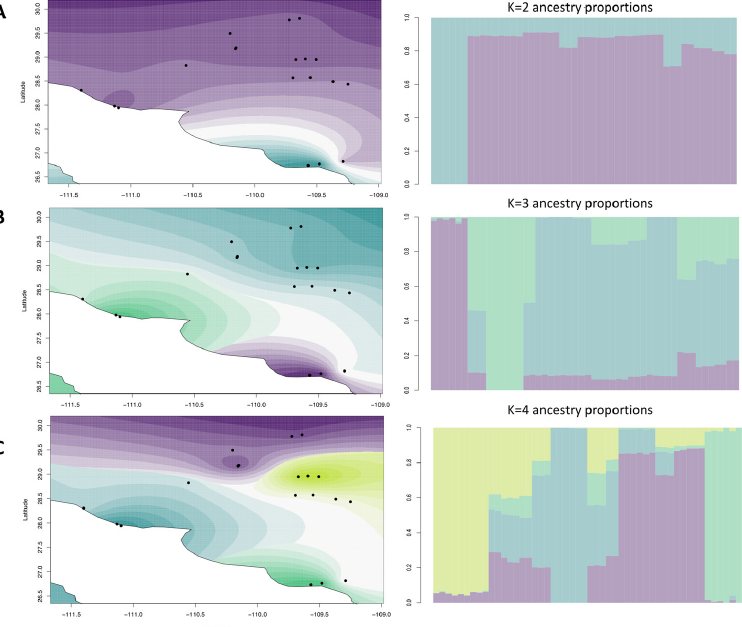
Figure 3. Interpolated ancestry proportions from TESS3R, demonstrating the geographic distribution of biologically meaningful genetic clusters ( K ) from 2 to 4 in Agave angustifolia var. pacifica from the state of Sonora, Mexico. Locations on each map are colored by the resulted dominant ancestry cluster, with transparency reflecting the percent ancestry of that cluster, with the largest value assigned as opaque. Each plot ( A – C ) corresponds to the respective values of K from 2 to